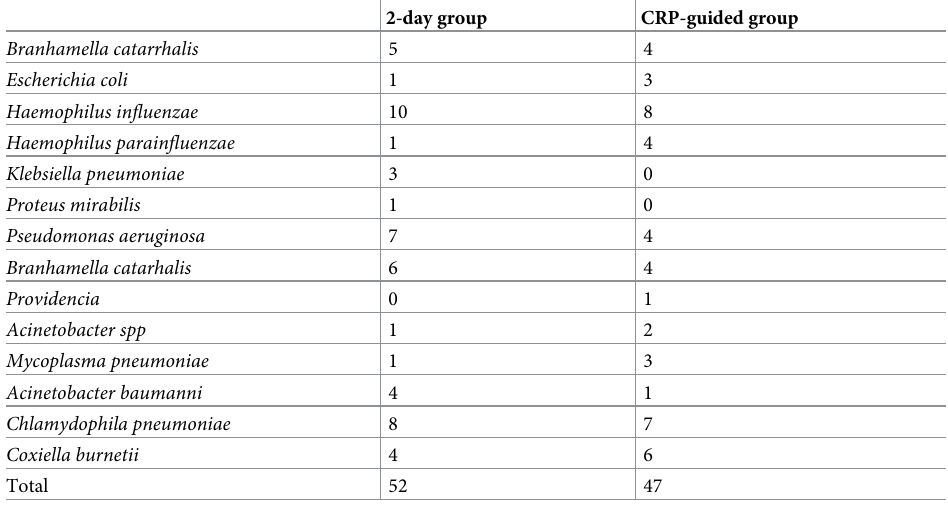
Table 2. Bacteriologic